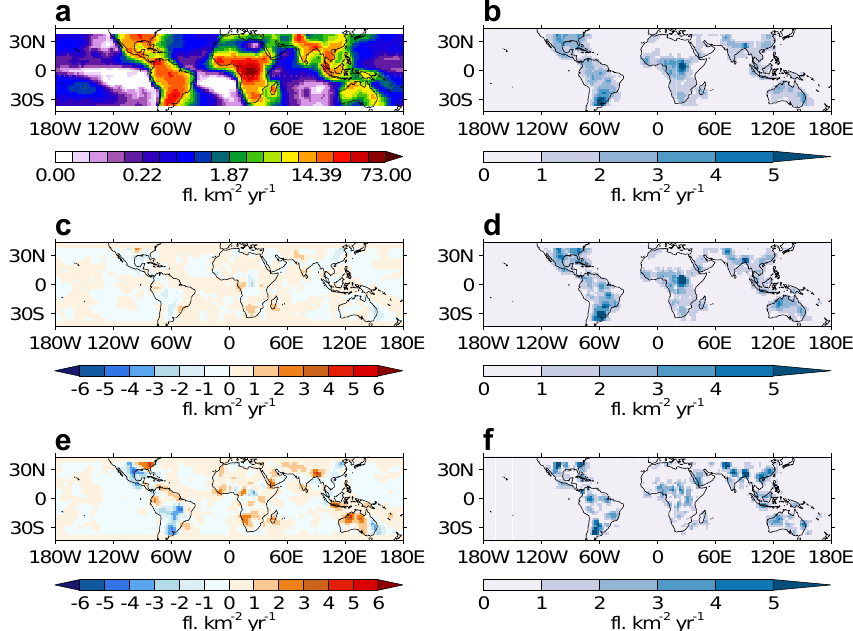
Figure 1. Average annual total LIS flash density spatial distributions of (a) the 10year climatology (2002–2011) and differences between the (c) 10year and 5year (2007–2011) and (e) 10year and 2year (2010–2011) climatologies. (b) , (d) and (f) show the standard deviations of annual LIS totals for each of the 10year, 5year, and 2year climatologies,